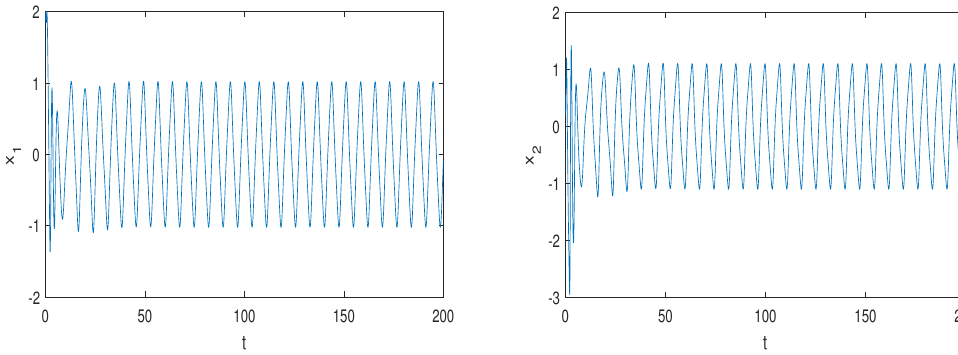
Figure 3. System (1) generates periodic solutions with a = 2, b = 2, c = 0.5, d =